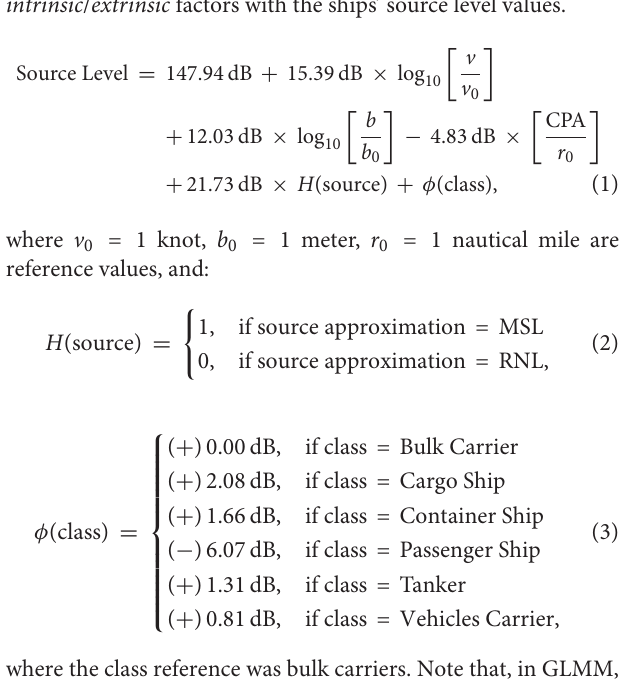
Table 3 and Equation (1) which indicate the correlation between intrinsic / extrinsic factors with the ships’ source level